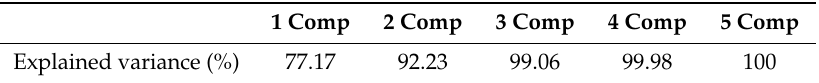
Table 4. Percentages of variance explained according to the number of components of the PLS model for prediction of the variable Tur mean in the El Vado CSO.